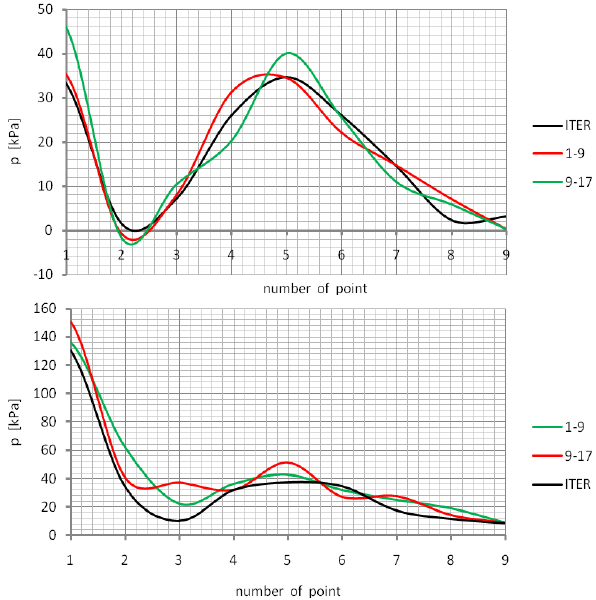
Figure 10: Intensity of normal interaction in the contact